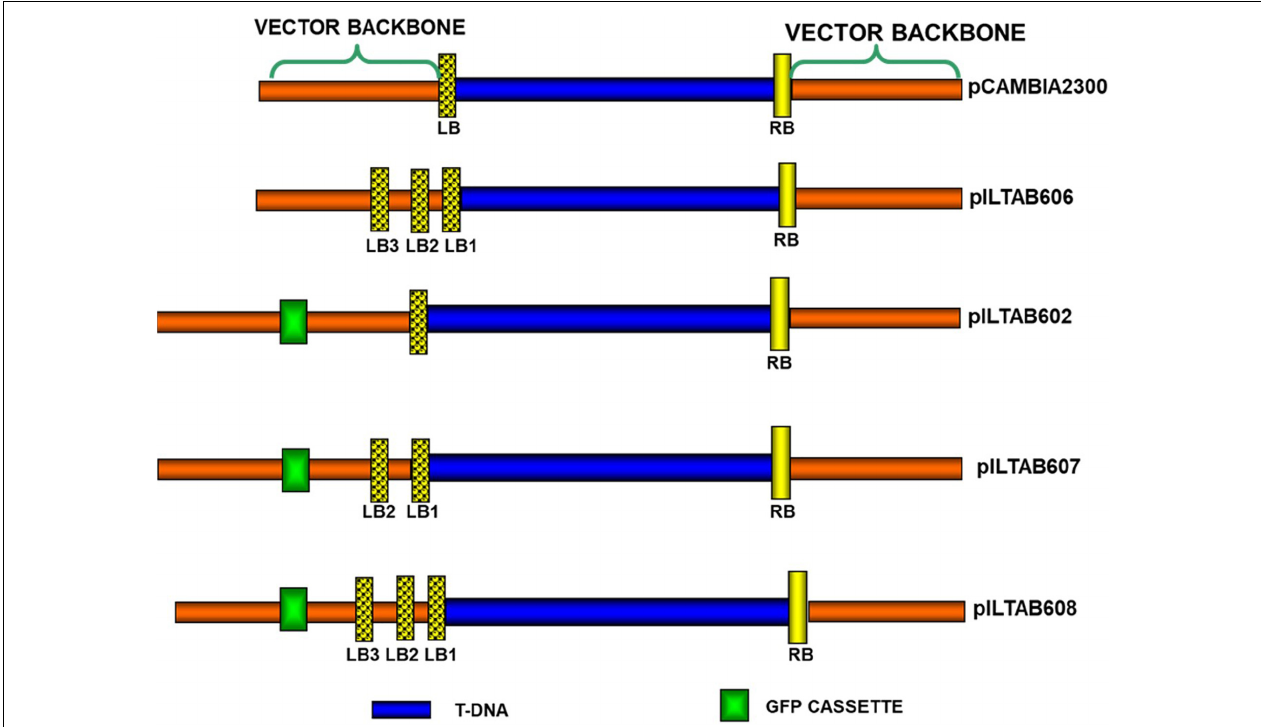
FIGURE 2 | Schematic representation of vectors containing multiple left borders and reporter genes in the vector backbone.